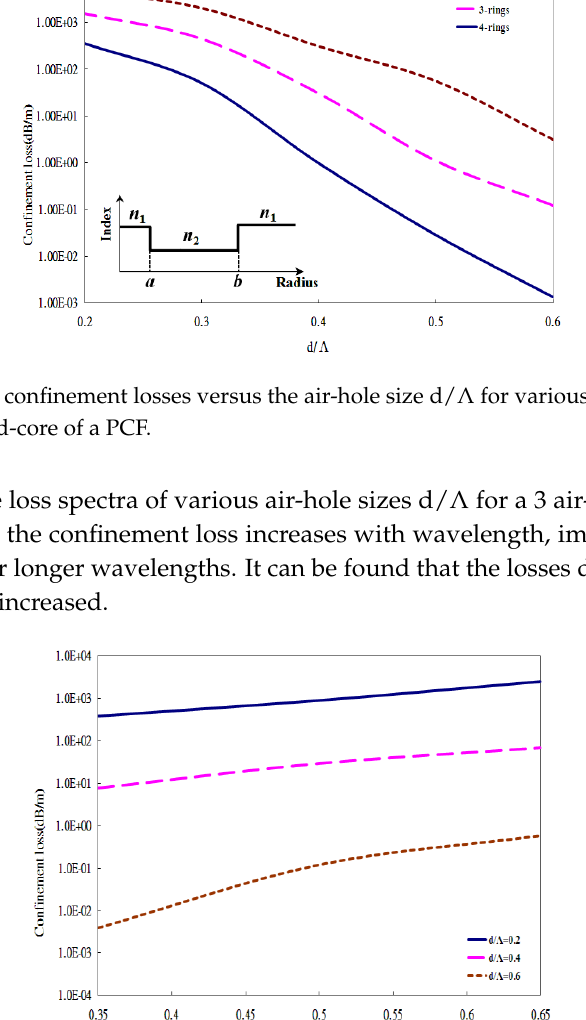
Figure 6. Wavelength responses of the real part (solid line) and the imaginary part (dashed line) of n eff for a 2 ring, 18 air-hole PCF when n silica = 1.46 and d/Λ = 0.6.